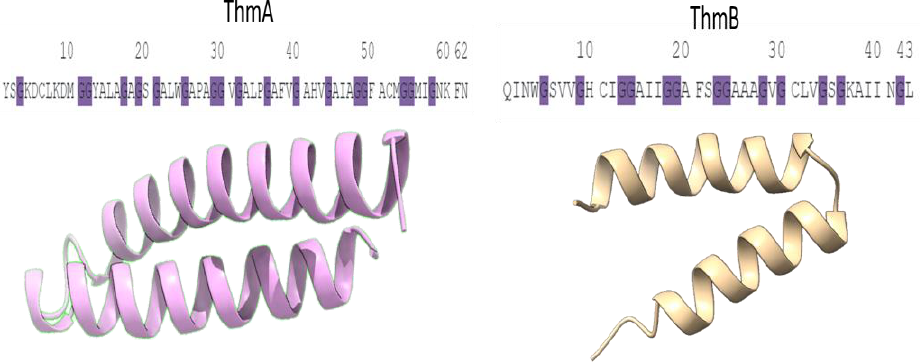
Figure 3. Amino acid sequences of the unmodified two-peptide subunit of thermophilin 13. The glycine residues in both peptides are matched in purple.